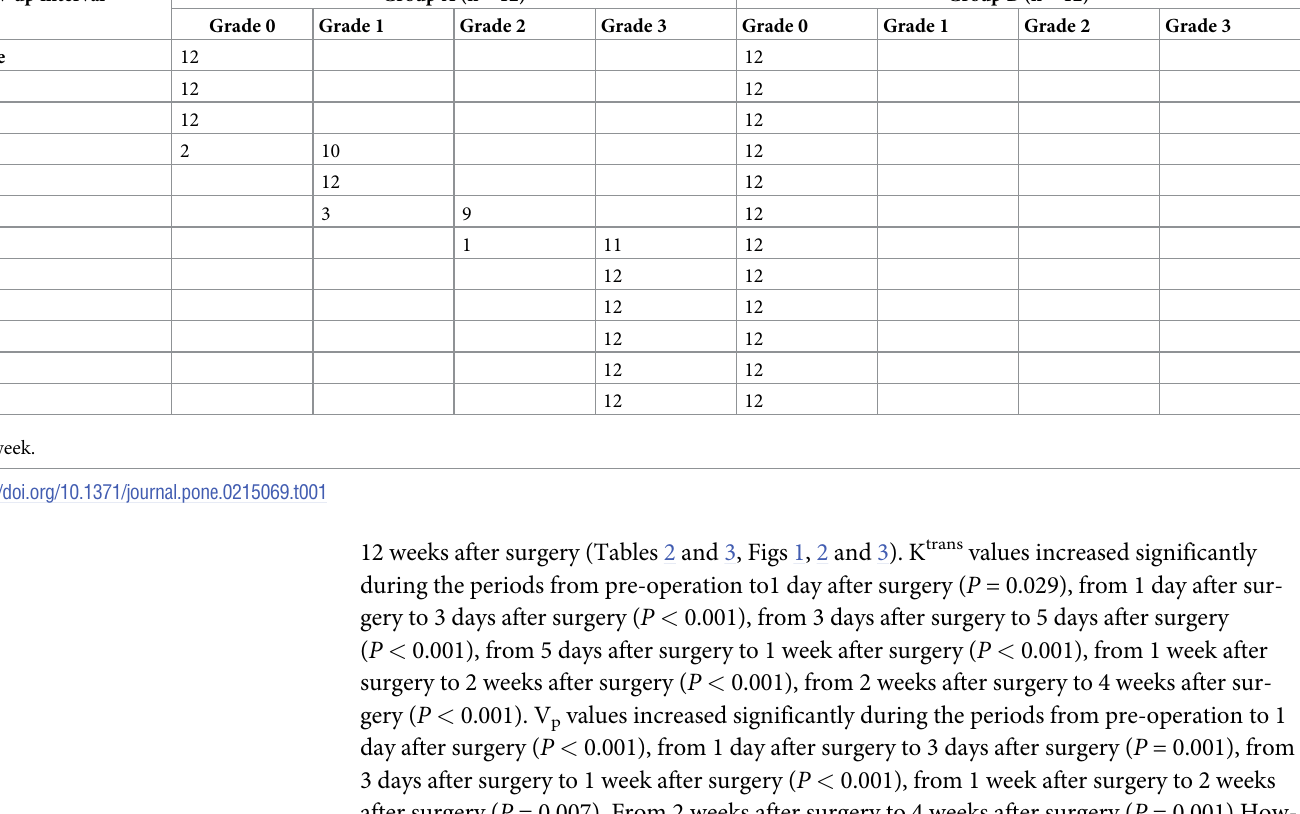
Table 1. Classification of signal intensity changes for each injury group.